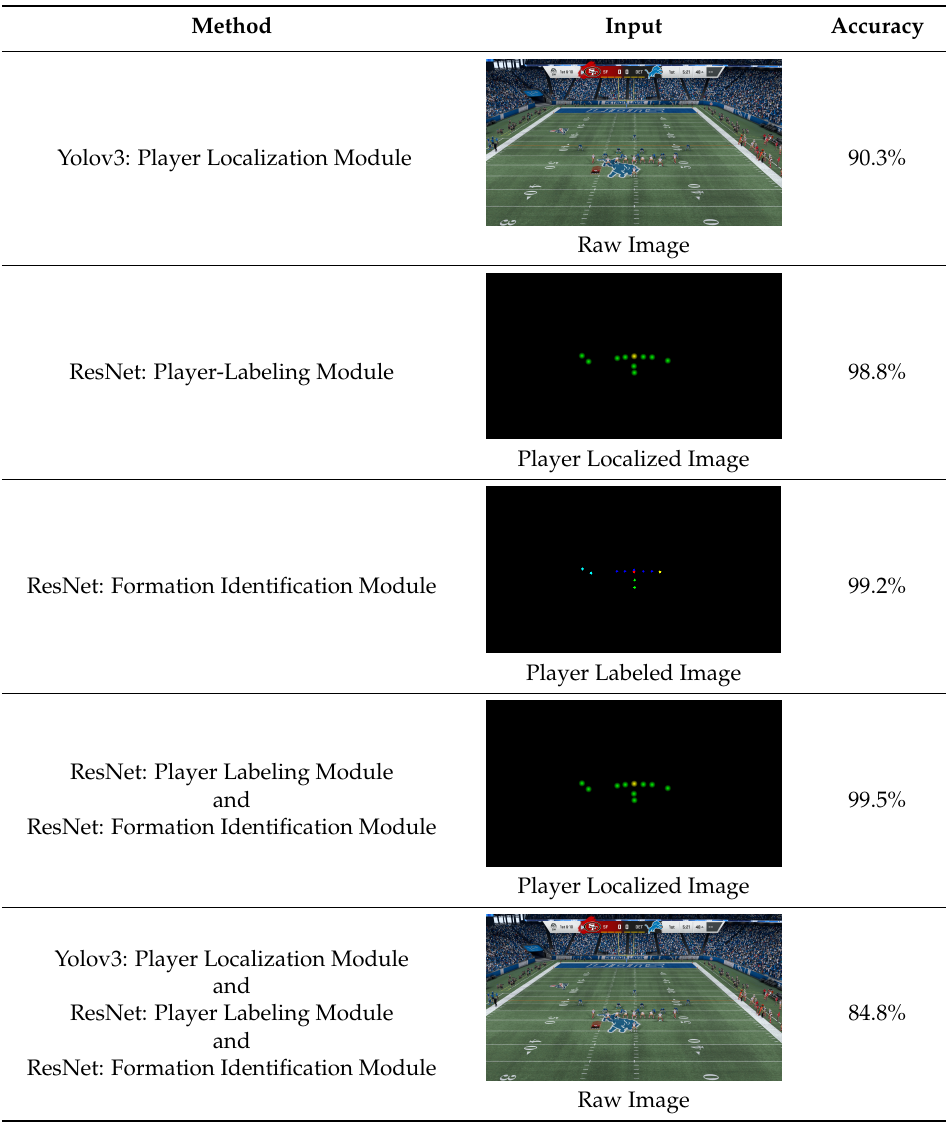
Table 4. This table describes the overall accuracy of various methods in the system. The final row in the table represents the overall accuracy of the entire system. For an analysis of why the accuracy went up for the combination of the second and third modules please see Section